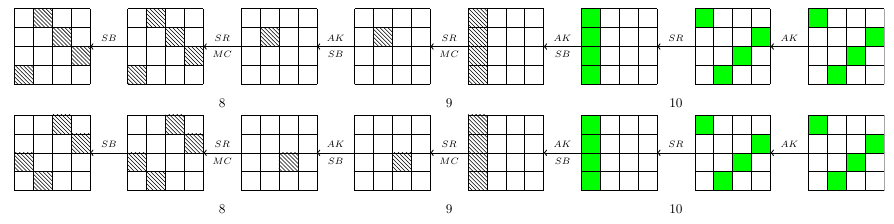
Figure 10: 2 other truncated differential characteristics for E 1 on